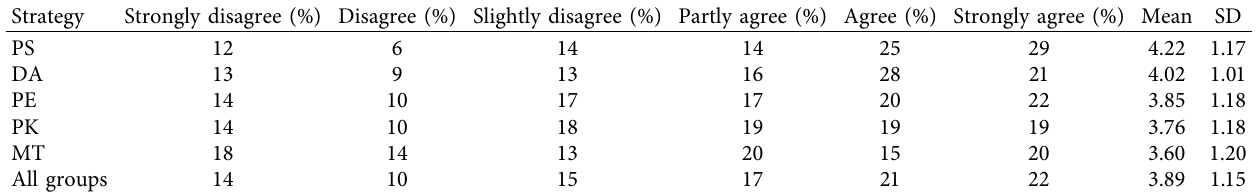
Table 3: Distribution of mean scores and SD of males’ responses to MLCS (subscale) ( N � 237). Strategy